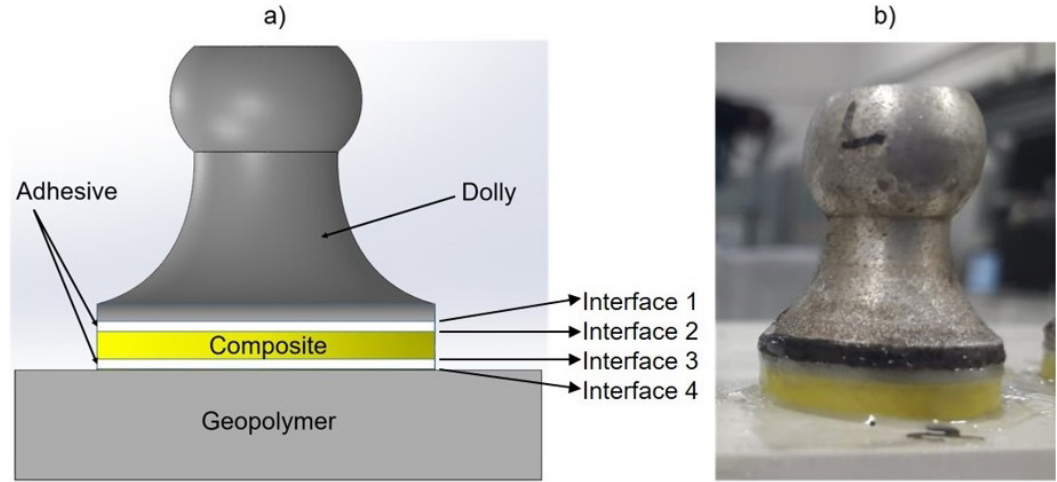
Figure 3. Pull off specimen (a) scheme and (b) real image.